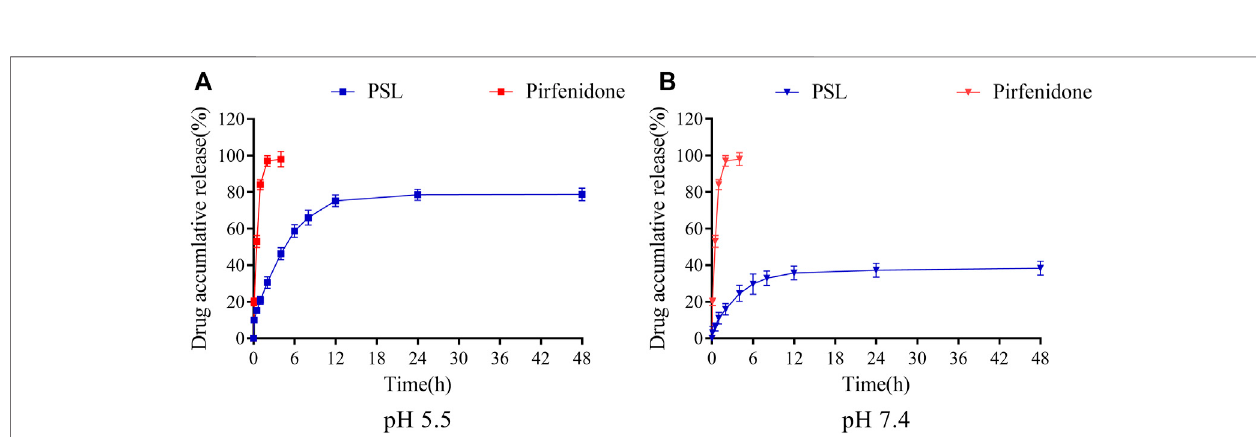
FIGURE 2 | In vitro release curve of PSLs and pirfenidone in PBS of pH 5.5 (A) and pH 7.4 (B) .